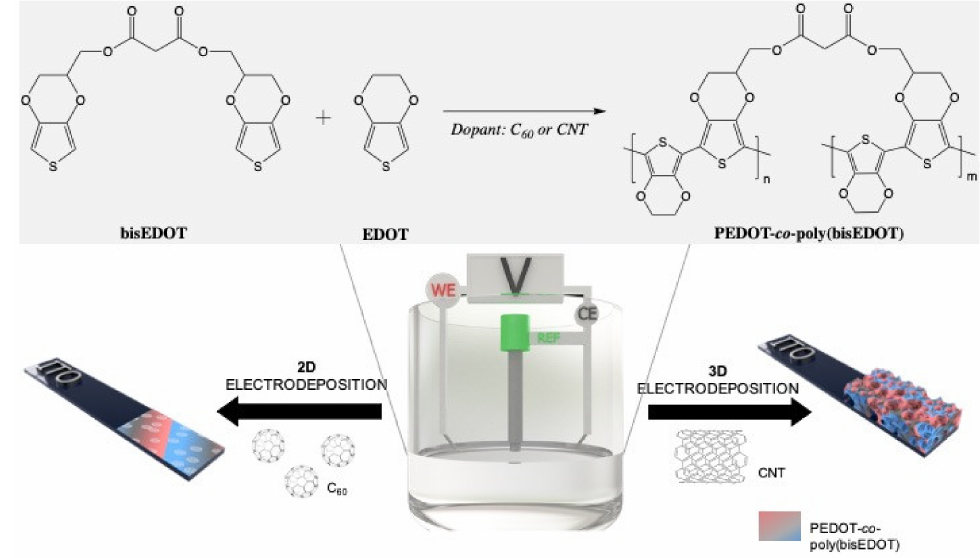
Figure 1. Electrochemical deposition of carbon nanomaterials throughout poly(bisEDOT) and PEDOT-co-poly(bisEDOT) copolymerization within 2D and 3D